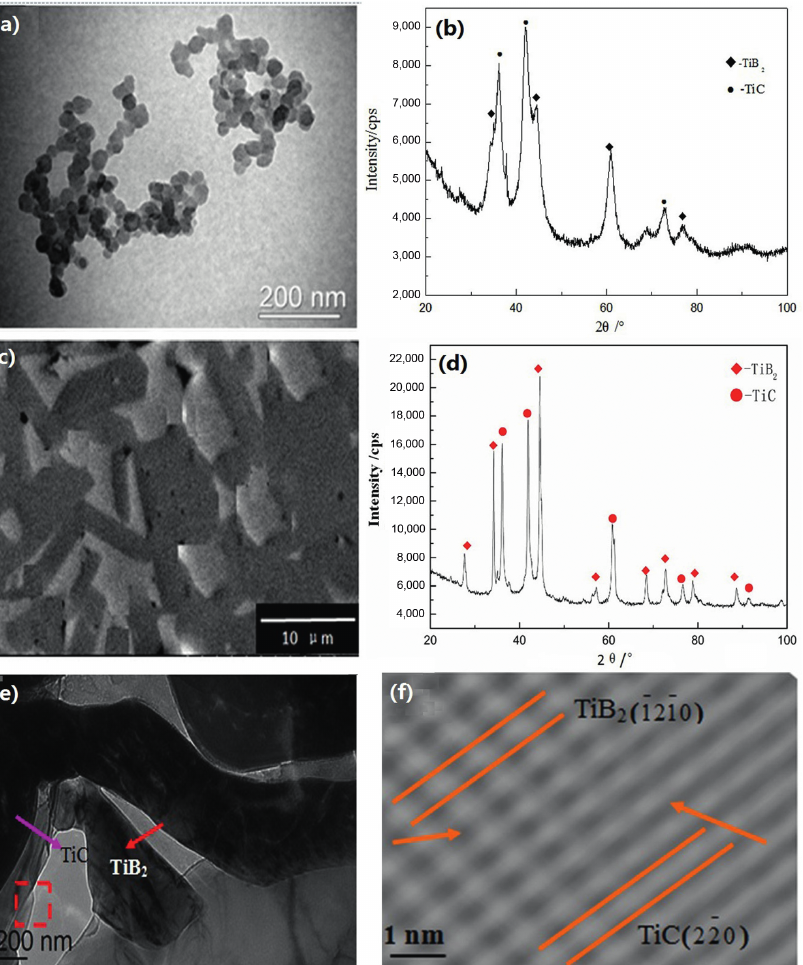
Figure 2: Images and XRD analysis of TiB 2 /TiC materials. (a, b) Micrographs and XRD of mechanical alloyed powders; (c, d) SEM and XRD analysis of TiB 2 /TiC composites; (e, f) TEM and HRTEM images between TiB 2 and TiC (selected areas in the areas marked by red dash